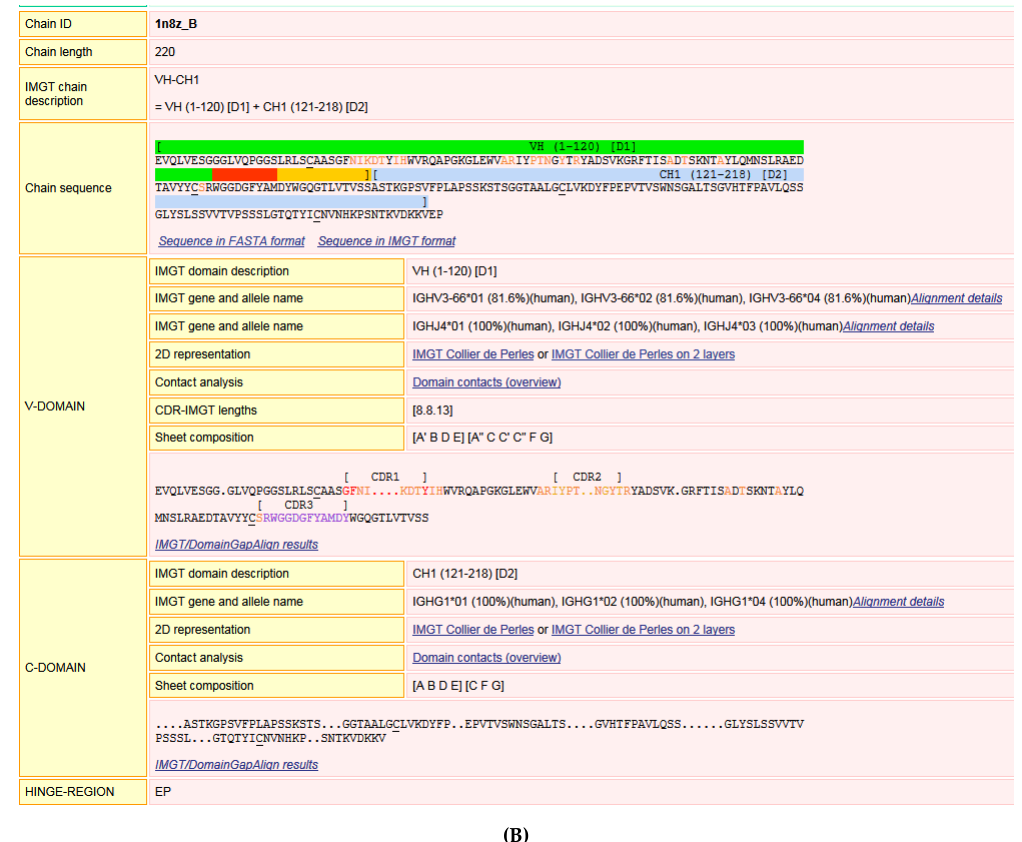
Figure 30. Chain details of the trastuzumab Fab ‘1n8z’ in IMGT / 3Dstructure-DB [57–59]. ( A ). L-KAPPA chain (1b8z_A). The chain sequence is identified as containing a V-KAPPA (V-REGION in green and J-REGION in orange) and a C-KAPPA (blue). ( B ). VH-CH1 chain (1n8z_B). The chain sequence is identified as containing a VH (V-REGION in green, N-AND-D-REGION in red and J-REGION in orange) and a CH1 (in blue). (With permission from M-P. Lefranc and G. Lefranc, LIGM, Founders and Authors of IMGT ® , the international ImMunoGeneTics information system ® , http://www.imgt.org).